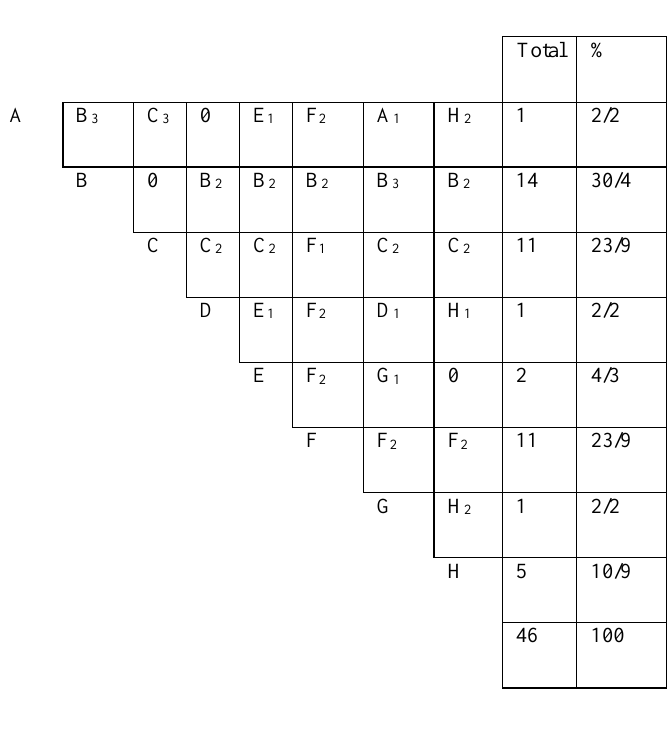
Figure 3. A Mudge diagram completed by a member of sample population